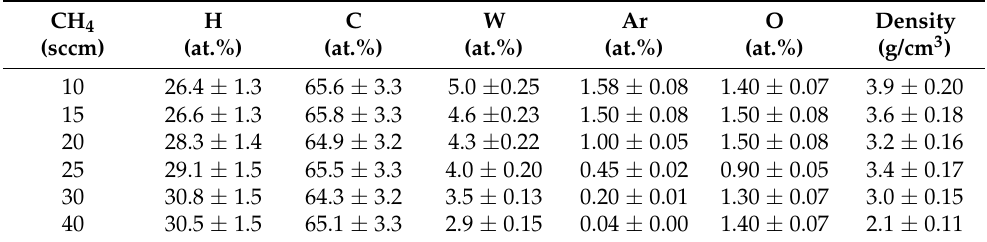
Table 1. Coating composition (by IBA) and density (by IBA and profilometer) together with deposition rate, all as a function of methane flow